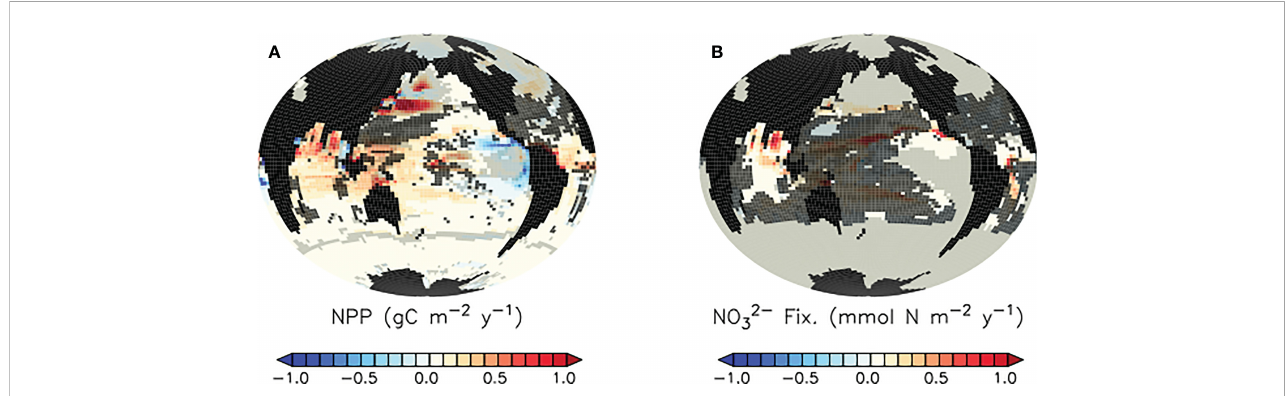
FIGURE 7 Model ensemble mean differences (SLOW small - CNTL) in simulated net primary production (A) and nitrogen fi xation (B) at the year 2100. Trends in regions shaded in light grey are highly variable in magnitude across the model ensemble. Trends in regions shaded in dark grey do not agree in sign across the model ensemble. Differences in SLOW big - CNTL are provided as Supplemental Figure S2.